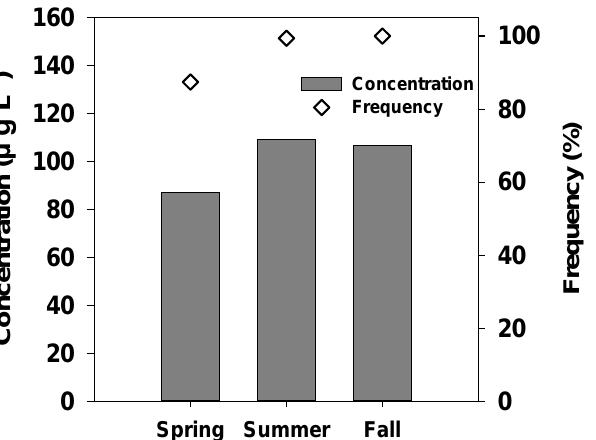
Figure 3. Seasonal cumulative concentrations and mean detection frequencies of heavy metals in the Han River watershed.